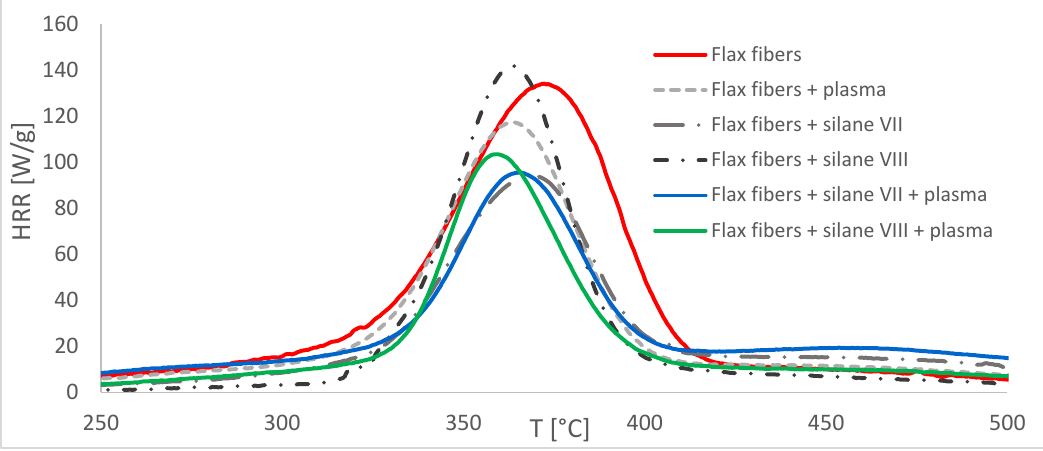
Figure 3. PCFC results for unmodified and modified fibers.